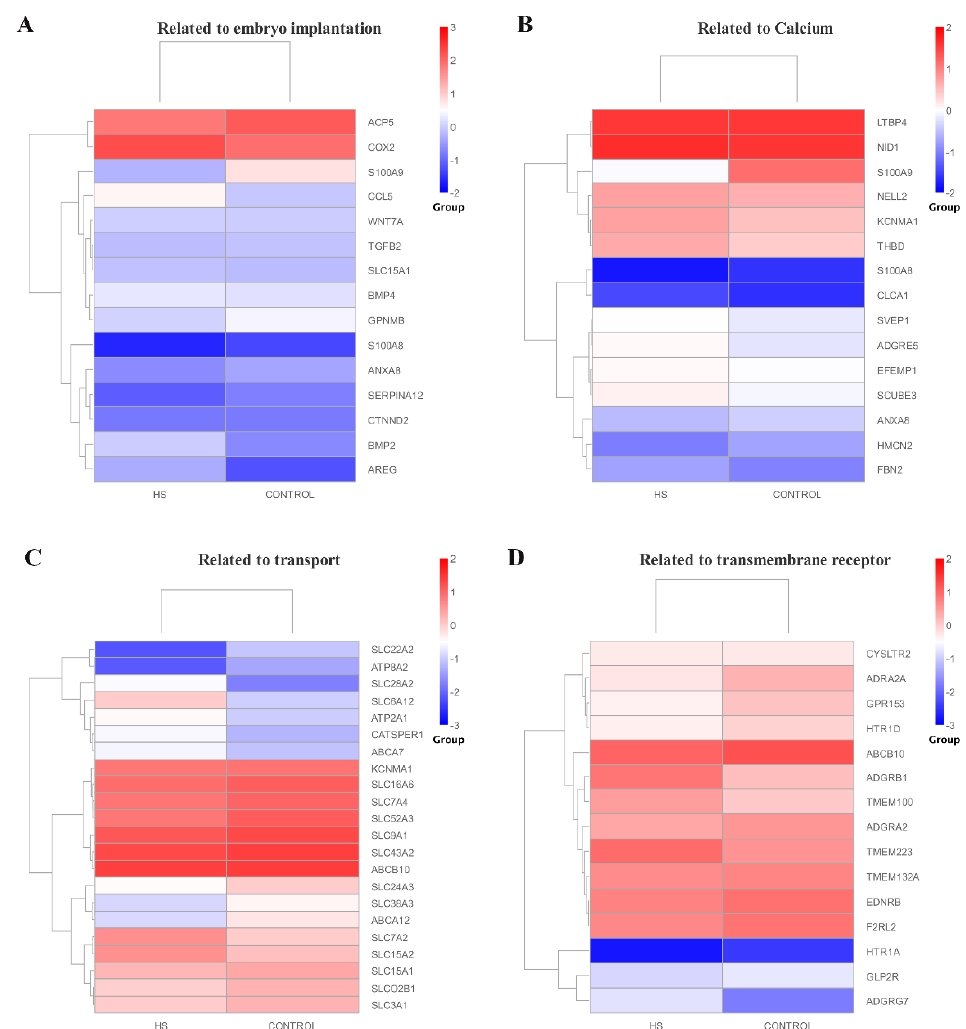
Figure 5. Cluster analysis of DEGs related to four major signaling pathways. ( A ) Embryo implanta- tion. ( B ) Calcium binding. ( C ) Transport. ( D ) Transmembrane receptor. The red color presents the up-regulated, and blue color indicates the down-regulated genes.